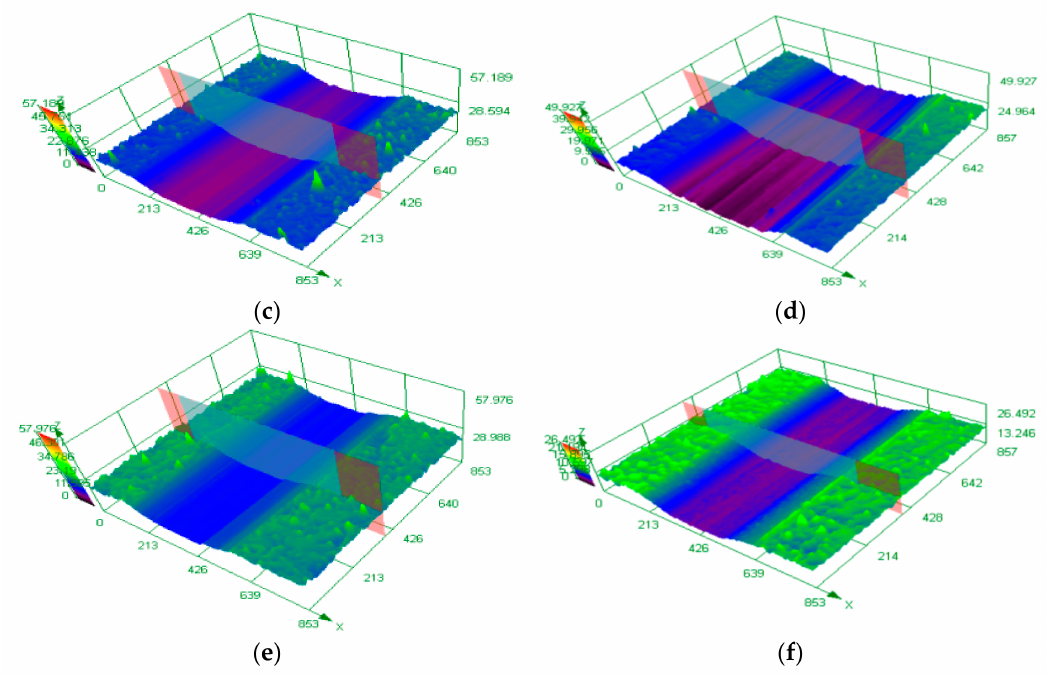
Figure 8. Three-dimensional morphology of wear marks. ( a ) 30 A · dm − 2 (J), ( b ) 20 A · dm − 2 ( c ) 30 A · dm − 2 ( d ) 40 A · dm − 2